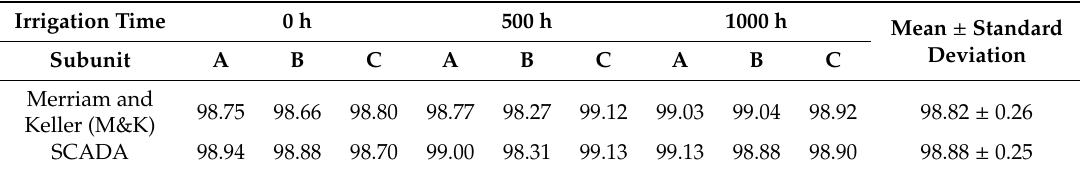
Table 2. Pressure distribution coefficients ( DU lp , %) of the three irrigation subunits (A, B, and C) at the beginning, after 500 h, and at the end of the experiment measured with the Merriam and Keller [9] and SCADA procedures.